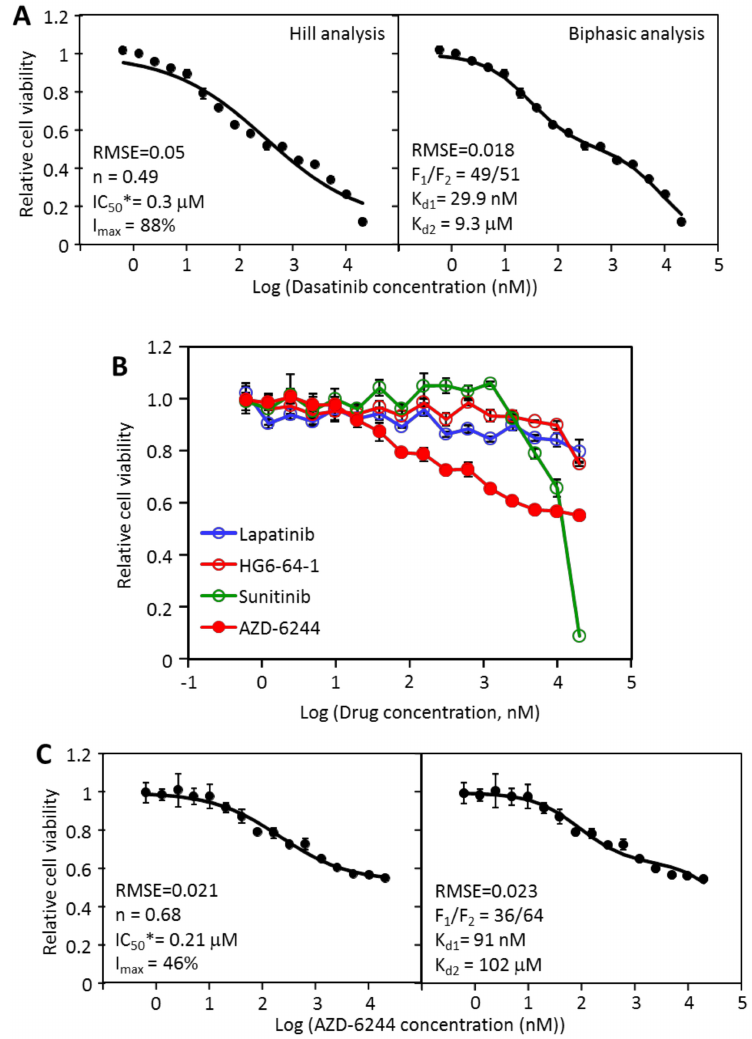
Figure 1. Analyses of the inhibition of MDA-MB-231 cell viability by dasatinib and AZD-6244. ( A ) the dose response data of MDA-MB-231 to dasatinib were analyzed by the Hill equation (left) and by the biphasic equation (right). The inhibitory parameters from each analysis are presented in the graphs; ( B ) inhibition of MDA-MB-231 by lapatinib, HG6-64-1, sunitinib and AZD-6244. ( C ) The dose response data of MDA-MB-231 to AZD-6244 were analyzed by the Hill equation (left) and by the biphasic equation (right). Each set of inhibition data represents six sets of data in two independent experiments in triplicates, with standard errors presented as error